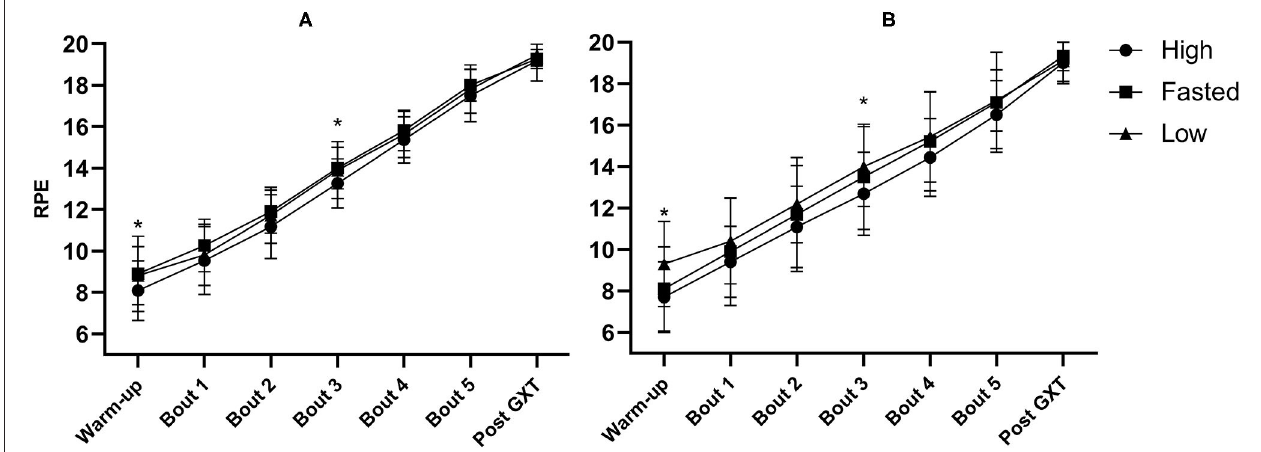
FIGURE 5 | Mean rate of perceived exertion (RPE) after warm-up, following all five exercise bouts at ∼ 50, 60, 70, 80, and 90% of ˙VO 2max and after the graded exercise test (GXT) in well-trained (A) and recreationally trained (B) . High, pre-event meal with high carbohydrate content; low, pre-event meal with low carbohydrate content; fasted, test in fasted state. *significant effect of pre-event meals after a follow-up test with both groups included ( p ≤